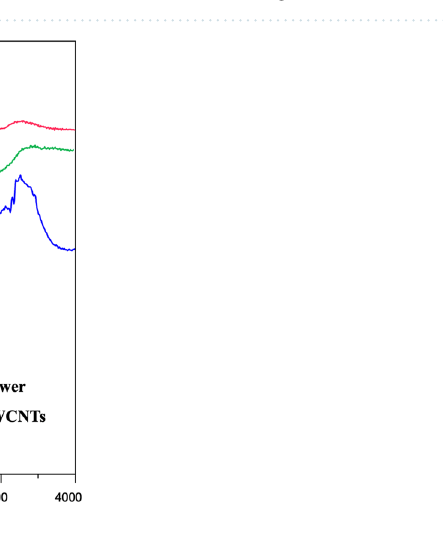
Figure 4. TEM images of ( a,b ) MWCNTs, ( c,d ) ZnO nanoflowers, ( e,f ) MoWO 4 , and ( g,h ) MW-Z@MWCNTs.